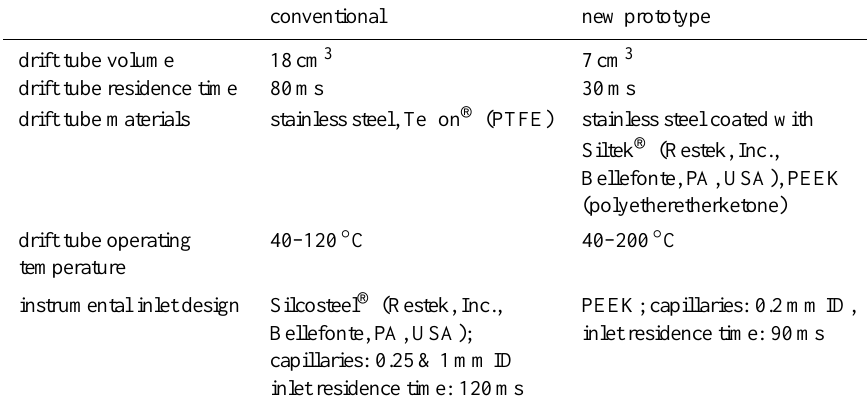
Table 1. Comparison of the PTR-MS equipped with conventional (PTR-MS HS2 of Ionicon Analytik) drift tube and HT-CIMS with new prototype drift tube and inlet